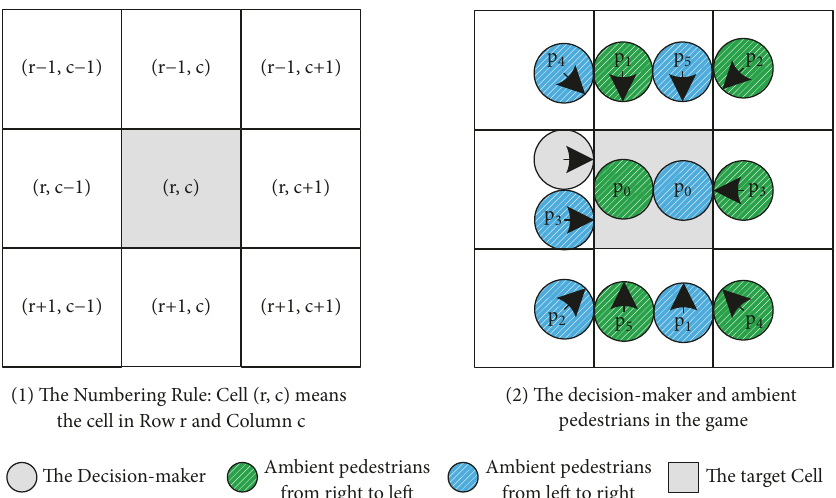
Figure 4: Pedestrians in the game. (1) demonstrates the cell numbering rule. (2) illustrates how ambient pedestrians affect the decision- maker’s expected comfort